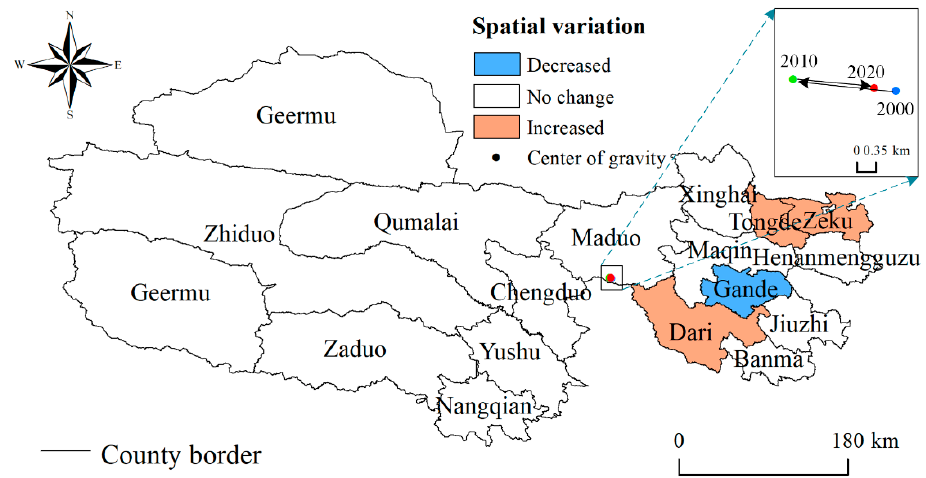
Figure 7. Spatial changes and shifts in the center of gravity of the ecological regulation index (ERI) in the Sanjiangyuan area during 2000–2020.